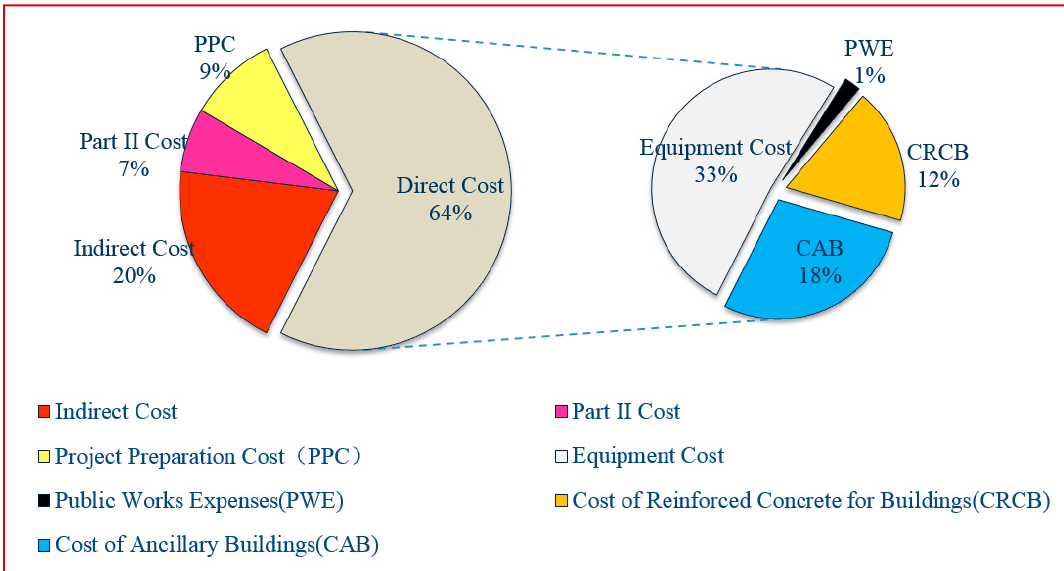
Figure 6. Total investment in infrastructure.